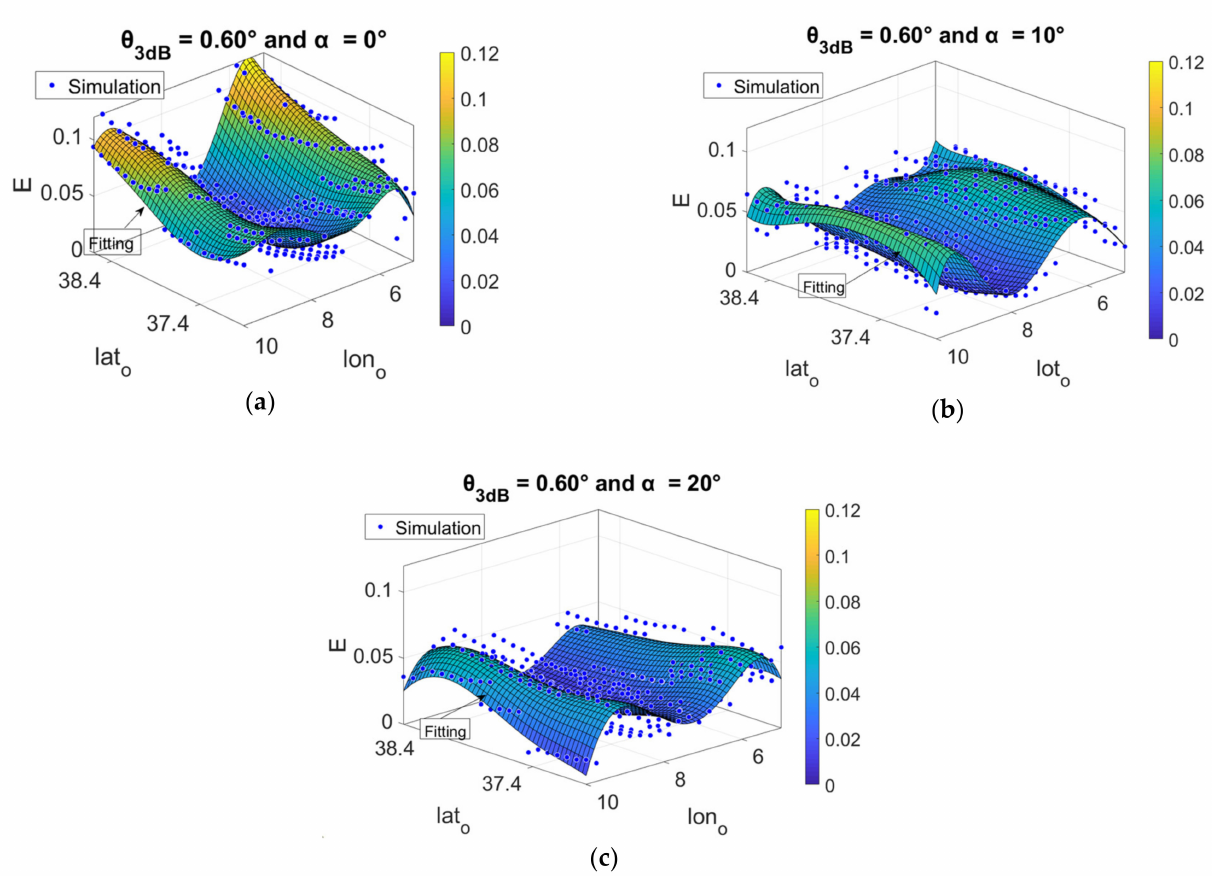
Figure 4. Normalized coverage error of regular multibeam coverage for Portugal, Spain, and France with an orbital position of 9 ◦ E. ( a ) θ 3dB = 0.60 ◦ and α = 0 ◦ . ( b ) θ 3dB = 0.60 ◦ and α = 10 ◦ . ( c ) θ 3dB = 0.60 ◦ and α = 20 ◦